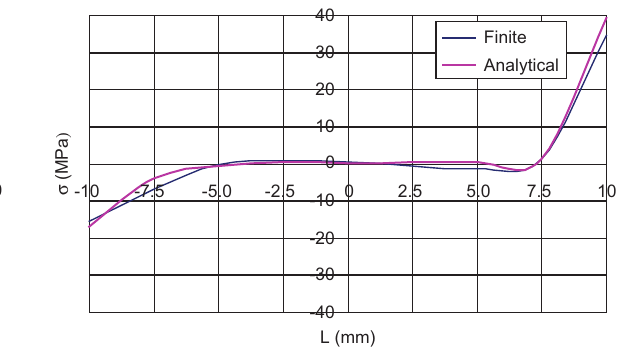
Figure 11 Peel stress distribution along the adhesive for = 3.2 t 0